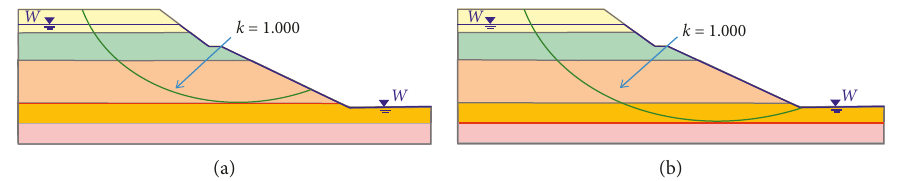
Figure 10: Example 4: results of the stability analysis by Bishop method. Slip surface at the design point: (a) failure model I, F (b) failure model II, F s (cid:28)